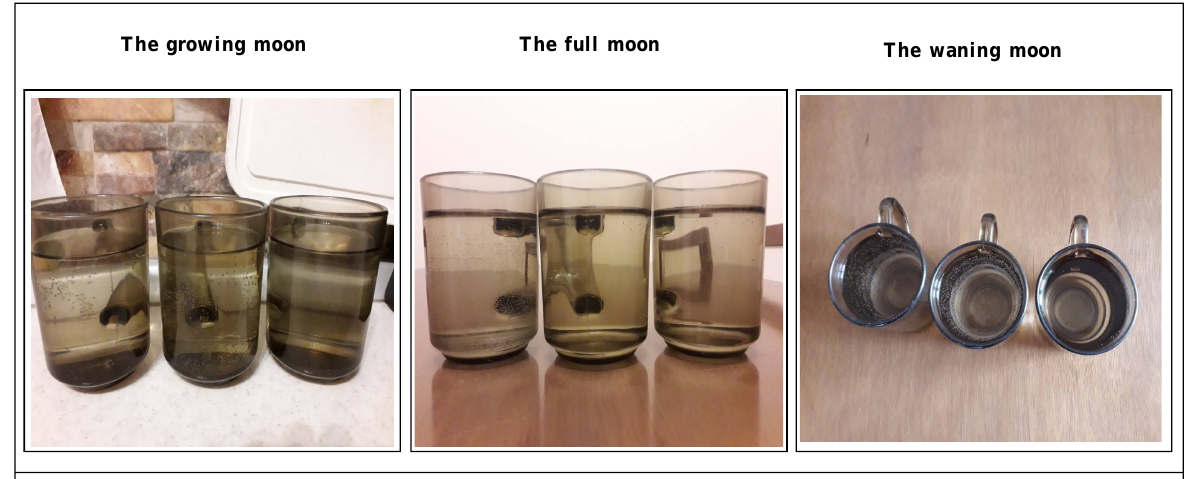
The full moonThe growing moon The waning